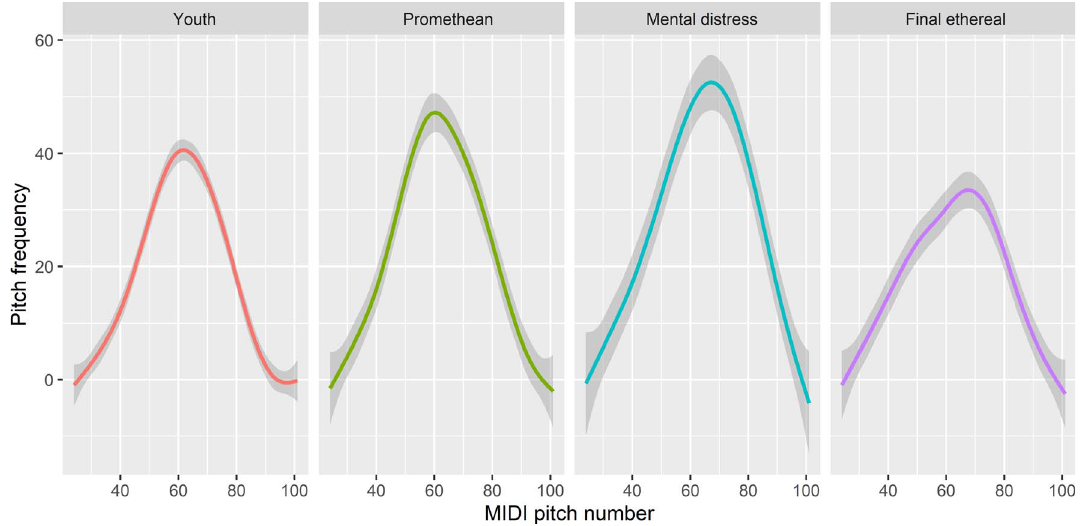
Figure 2. Two stages of the hierarchical model used to study the link between pitches frequencies with periods of composition.